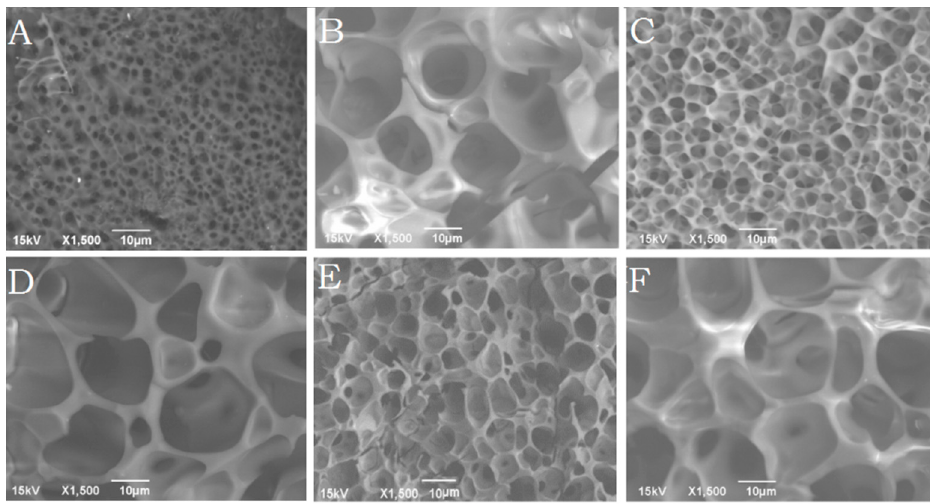
Figure 5. Cryo-SEM images of porous morphology of freshly cut surfaces of the polymeric delivery systems loaded with A , B : Risperidone (30 and 60 days), C , D : Insulin (30 and 60 days), and E , F : BSA (30 and 60 days), maintained at body temperature (5 min sublimation). Table 2. Average size of pores formed in the delivery systems loaded with different molecules. Incorporated Molecules Day 30 (Average Pore Size) Day 60 (Average Pore Size) Blank (Polymer only)